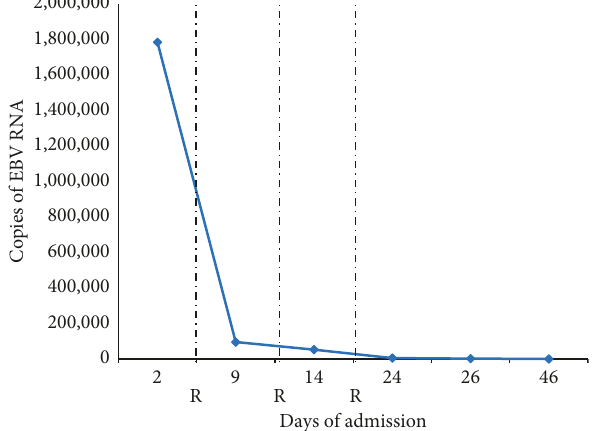
Figure 1: Epstein–Barr virus (EBV) viremia through days of ad- mission. R � Rituximab administration at 375mg/m 2 .